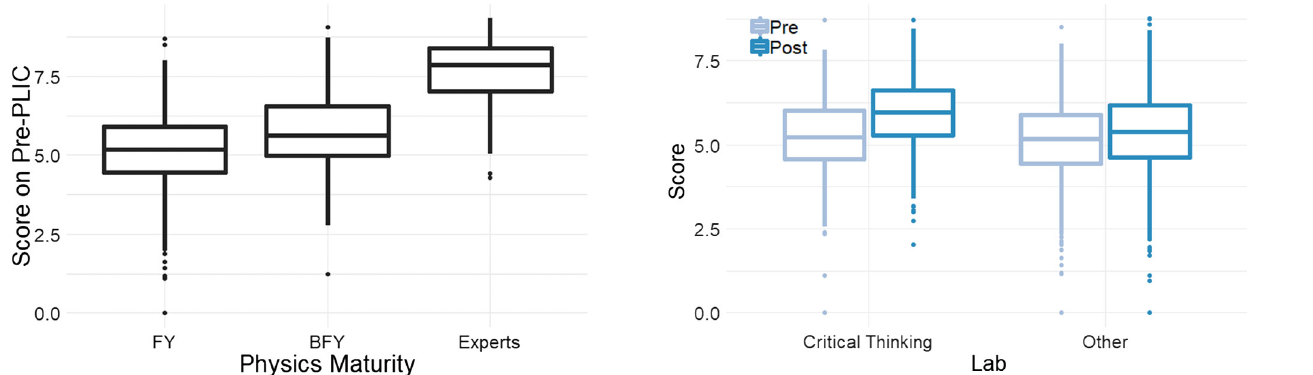
FIG. 3. Boxplots comparing presurvey scores for students in FYand BFY labs, and experts. Horizontal lines indicate the lower and upper quartiles and the median score. Scores lying outside 1 . 5 × IQR (inter-quartile range) are indicated as outliers.